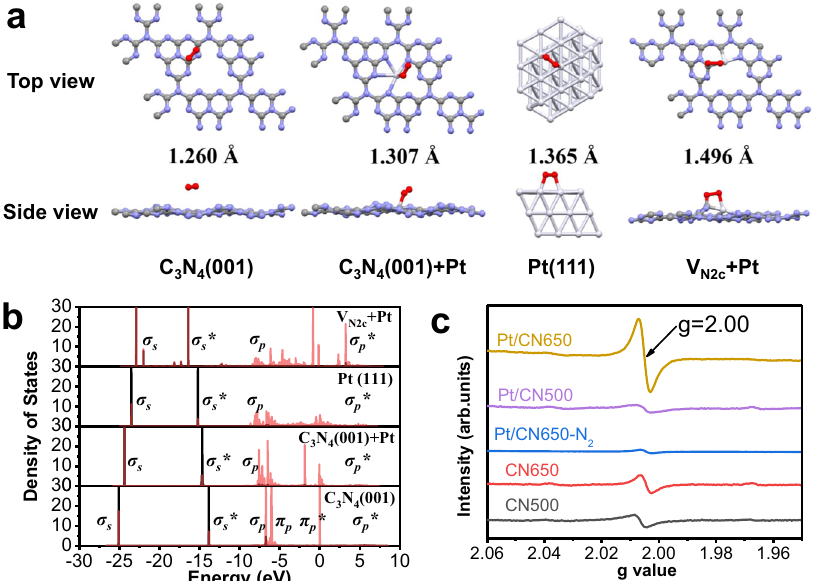
2.06 2.04 2.02 2.00 1.98 Fig. 6 Mechanistic insights of catalytic toluene oxidation over the catalysts. a The structures of O 2 adsorbed on pure C 3 N 4 (001), C 3 N 4 (001) + Pt, Pt (111), and V N2c + Pt (gray, purple, white, and red represents C, N, Pt, and O). b Partial density of states (PDOS) of the adsorbed O 2 (The black and red lines represent the O 2 s and 2 p orbitals, respectively. The molecular orbitals are also denoted). c EPR spectra of carbon nitrides and supported Pt catalysts at room temperature in air and N 2